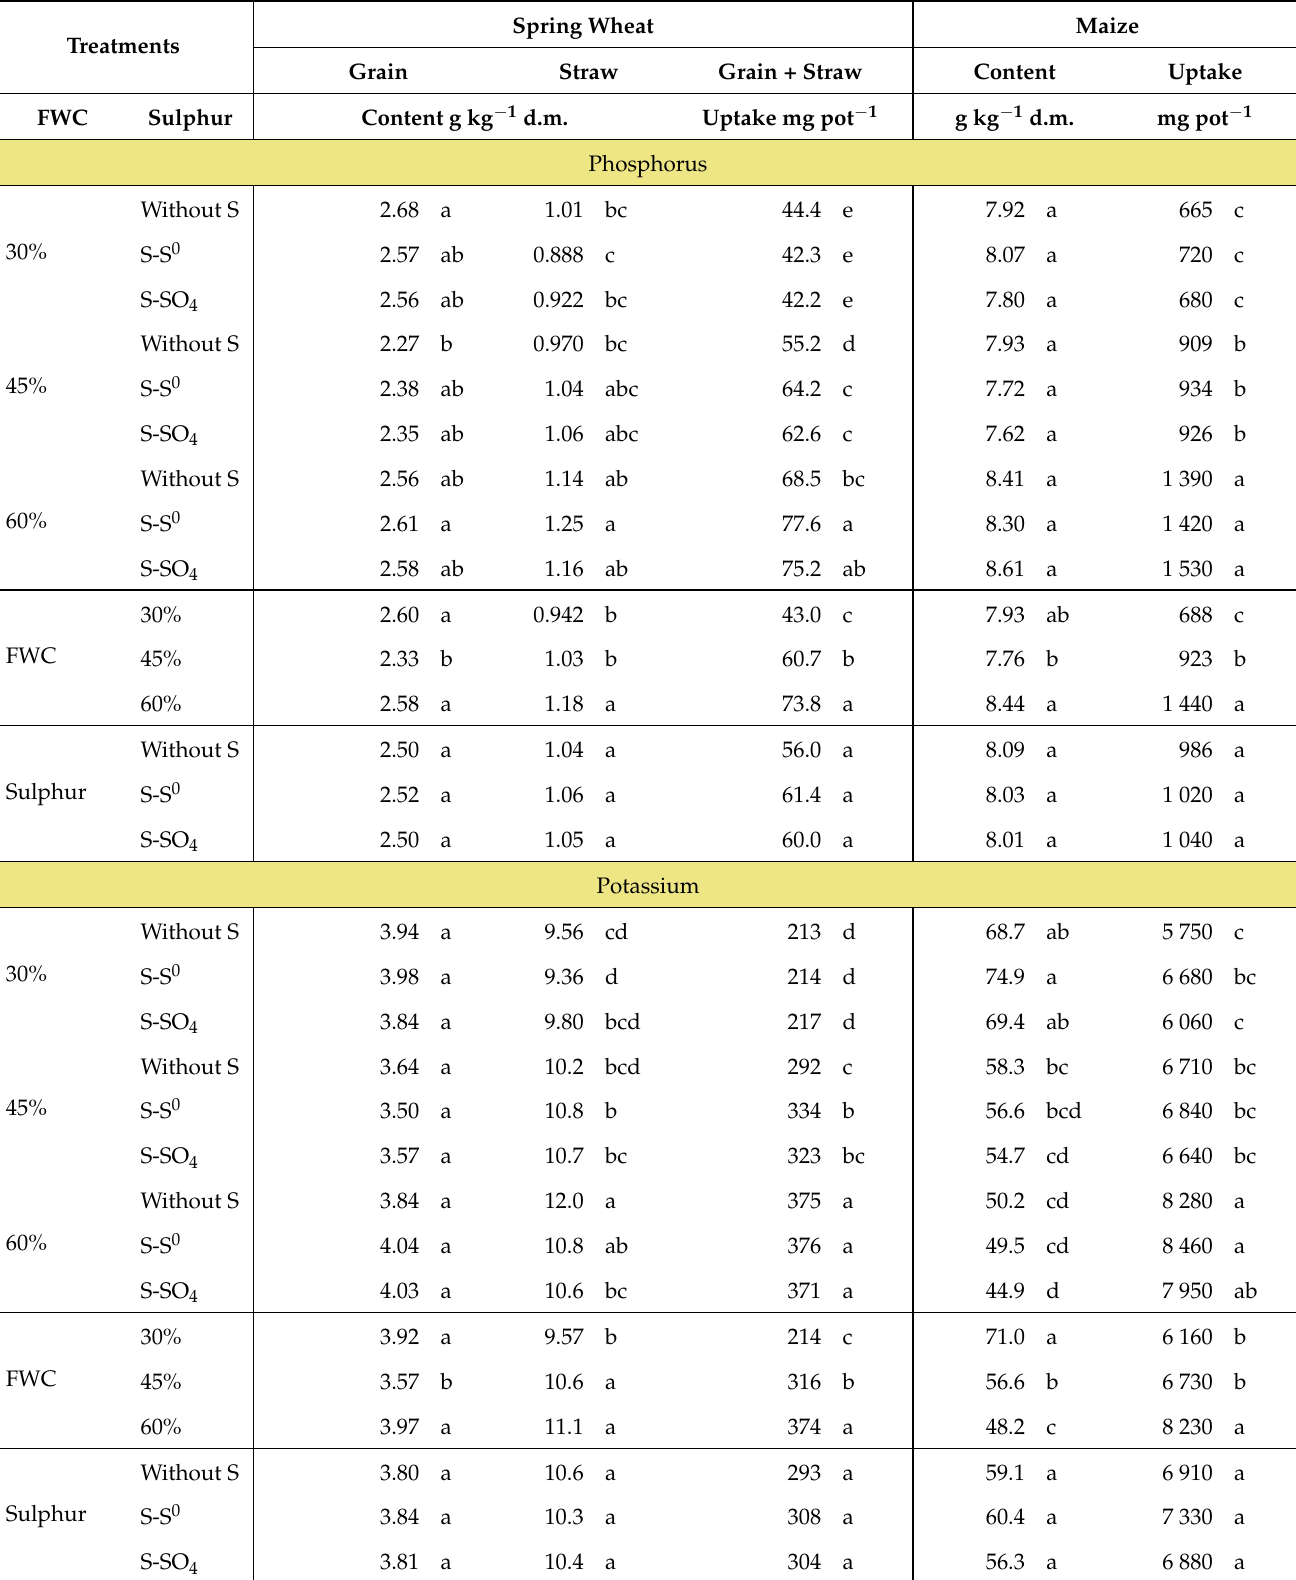
Table 4. Phosphorus and potassium content and uptake in cultivated plants. Values indicated by the same letter are not significantly different ( α =